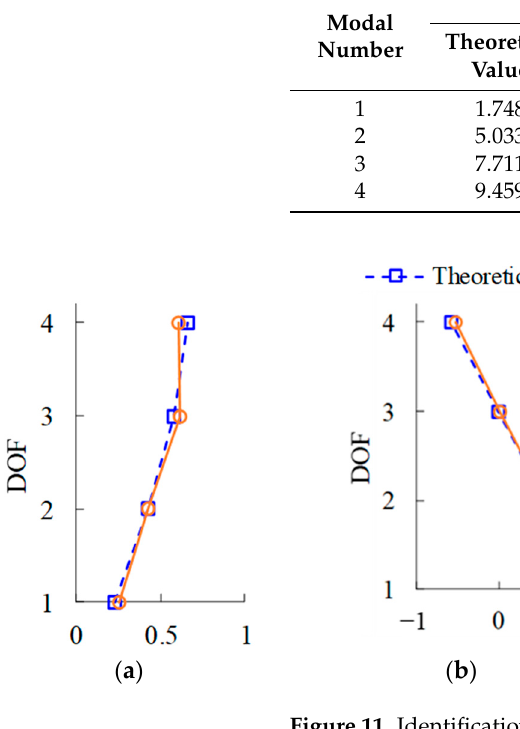
Figure 11. Identification results of the modal vibration pattern. ( a ) 1st order; ( b ) 2nd order; ( c ) 3rd order; ( d ) 4th order.